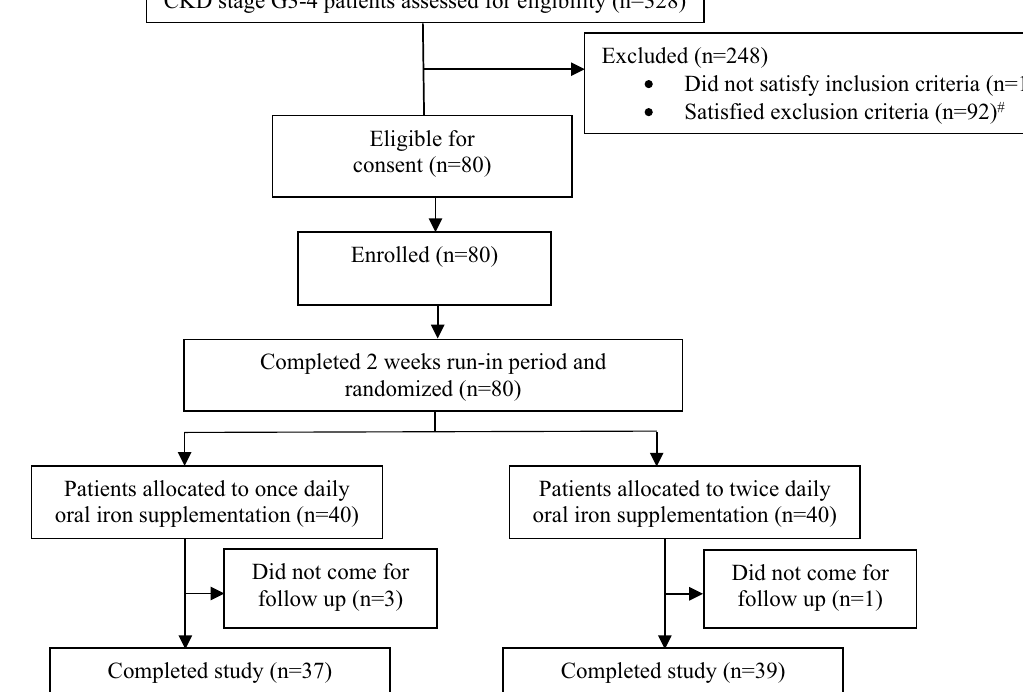
Figure 1. Study enrolment and follow up. *Subjects who did not satisfy inclusion criteria (n = 156): age 18–70 years (n = 6), eGFR by CKD-EPI 15–60 ml/min/1.73 m 2 (n = 84), serum TSAT concentrations ≤ 30% and serum ferritin ≤ 500 mg/l (n = 49), clinically stable course as judged by the treating physician for last 3 months (n = 17). # Subjects who satisfied exclusion criteria (n = 92): blood hemoglobin < 10 g/dl (n = 36), current use or use within last 3 months of oral or intravenous iron preparations (n = 17), suspected or known diagnosis of autoimmune disease (n = 6), past or present diagnosis of malignancy (n = 2), known diagnosis of chronic liver disease (n = 4), gastro-intestinal bleeding or any form of gastro-intestinal disease predisposing to malabsorption (n = 3), history of allergic reactions to any form of oral or intravenous iron preparations (n = 1), current intake of gastric acid inhibitors (H2 receptor blockers, proton pump inhibitors) (n = 16), history of prior non-compliance with oral iron therapy due to gastro-intestinal side effects (n = 5), current use or use within last 6 months of immunosuppressive drug therapy (n =